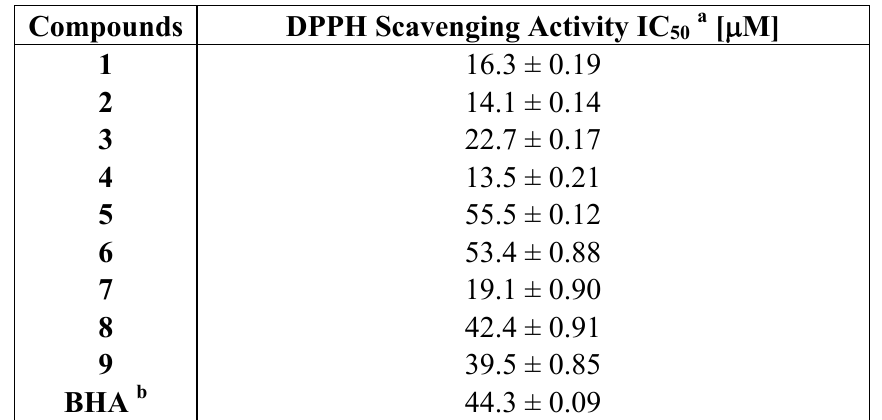
Table 1. IC (µ M ) values of compounds 1–9 in the DPPH antioxidant assay. 50